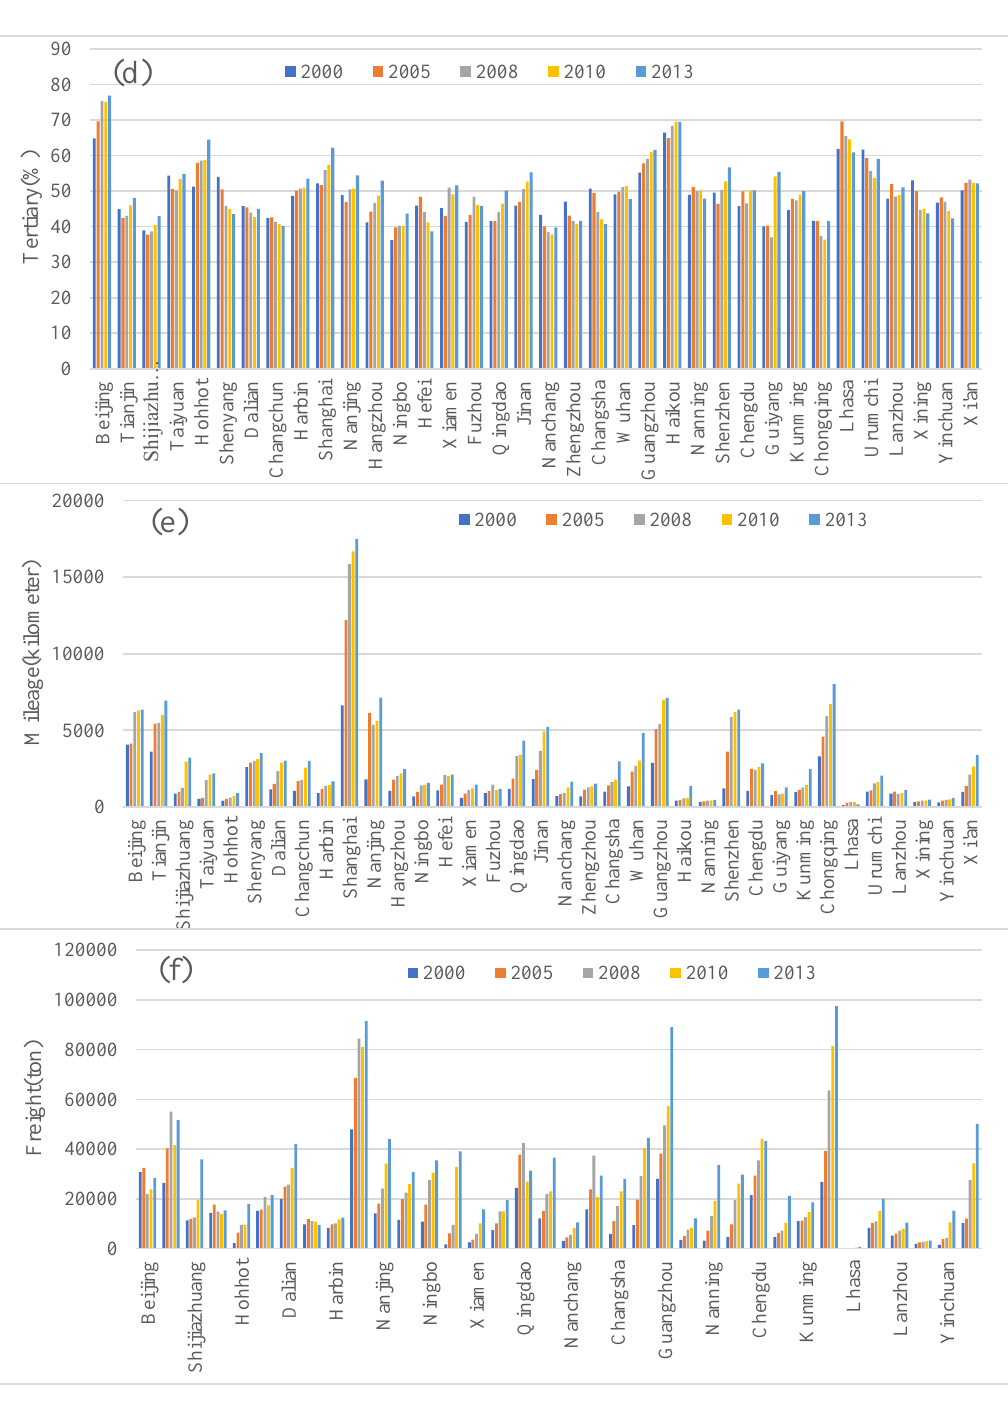
Figure 8. Six socioeconomic variables of various cities in ( a ) 2000, ( b ) 2005, ( c ) 2008, ( d ) 2010, and ( e ) 2013.